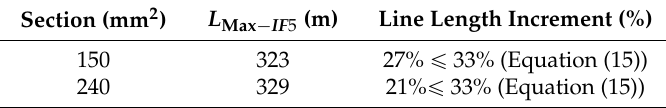
Table 8. Admissible line length with the doubling of the neutral conductor section. Results of Equation